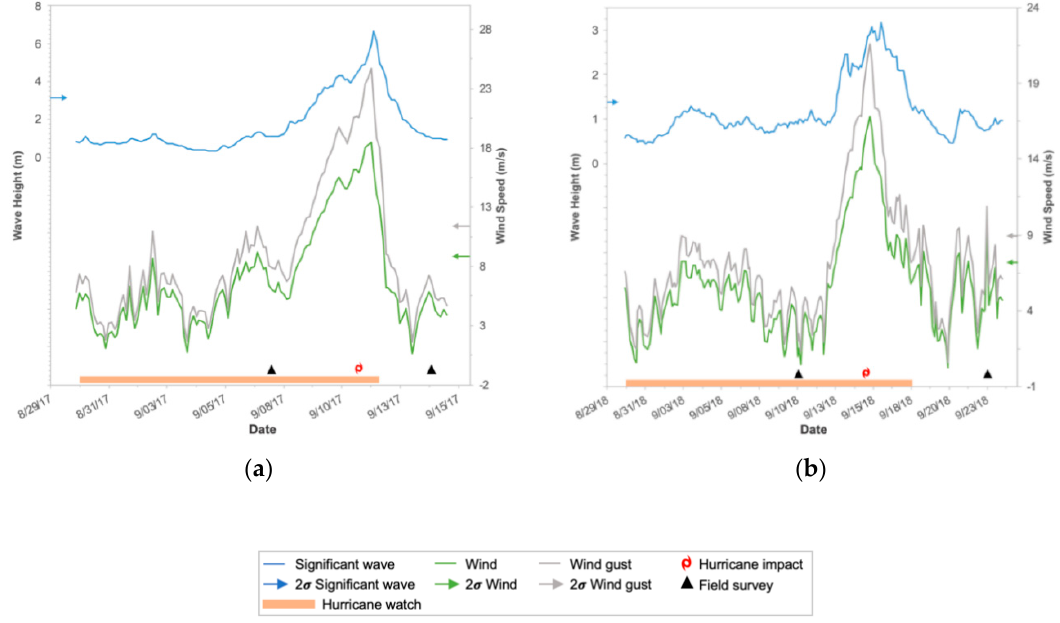
Figure 4. Significant wave heights, wave speeds, and wind gusts during the ( a ) Irma and ( b ) Florence study periods.